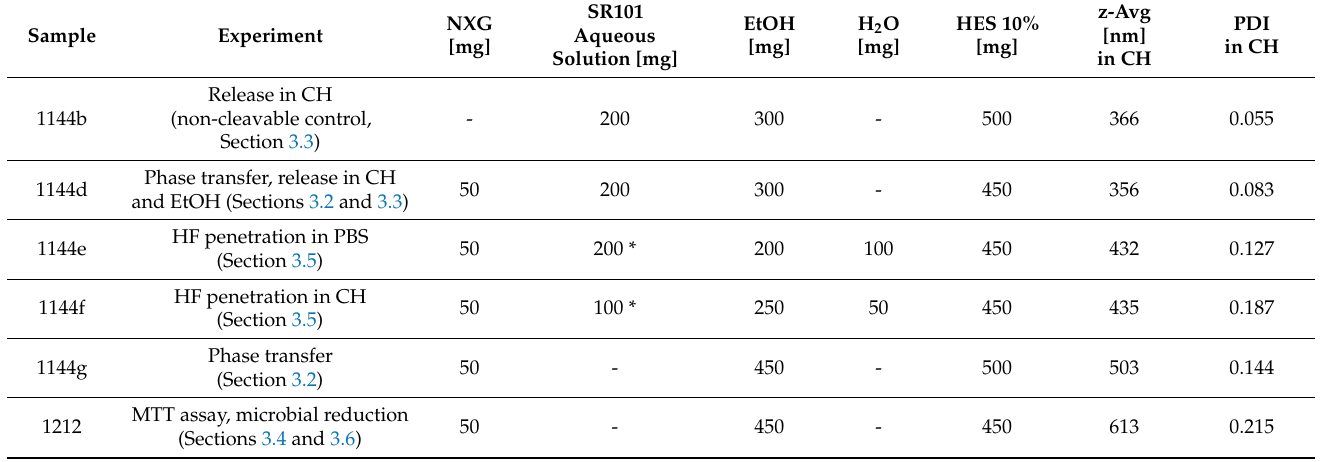
Table 1. Composition of the dispersed phase of the HES-NC samples and their DLS characterization